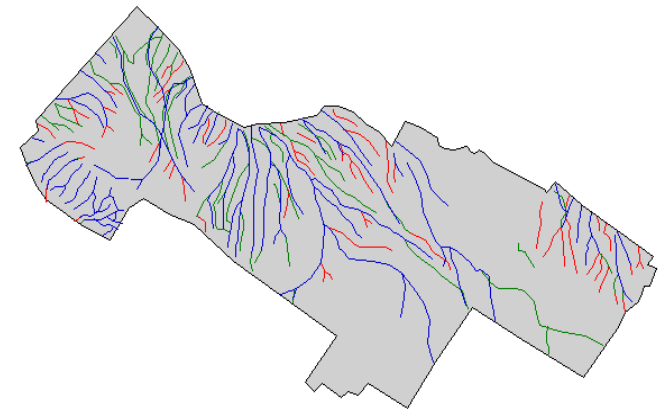
Figure 8. The Dynamics of the planar ephemeral gully network pattern for Landsat satellite images at di ff erent time (Samara River basin, area No. 8). Red—2015, green—2000, and blue—1988. Medveditsa river basin. The dynamics of ephemeral gully erosion at 10 interfluves (areas 23 to